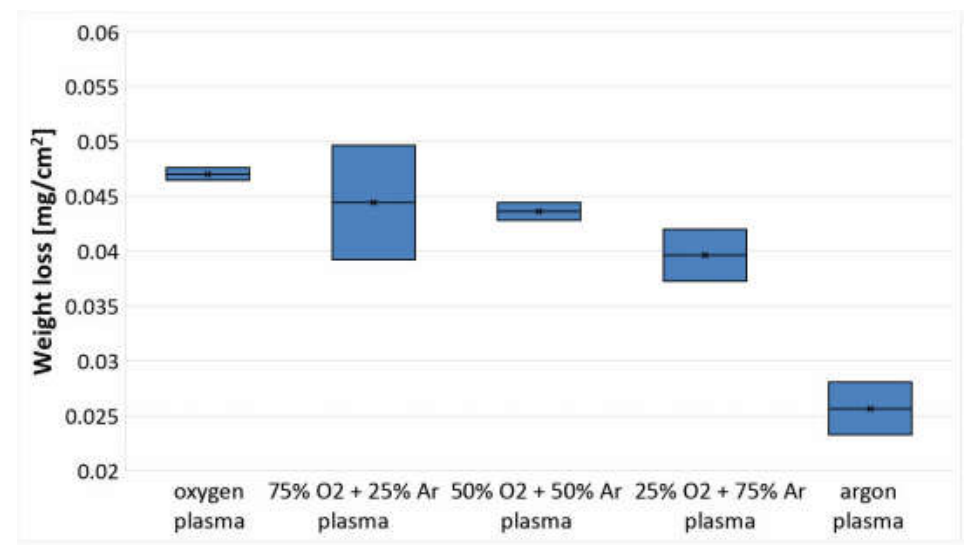
Figure 7. Changes in sample weight as a result of plasma modification of PLA with different gases and their mixtures (box plot chart for 2 measurements, where box height shows minimum, average and maximum).